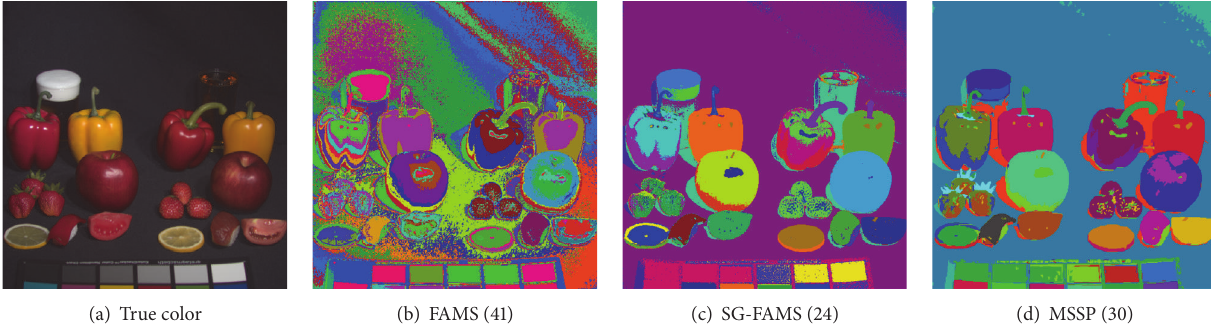
Figure 7: Clustering results on fake and real food image. The number of clusters is shown in parentheses in the respective caption.